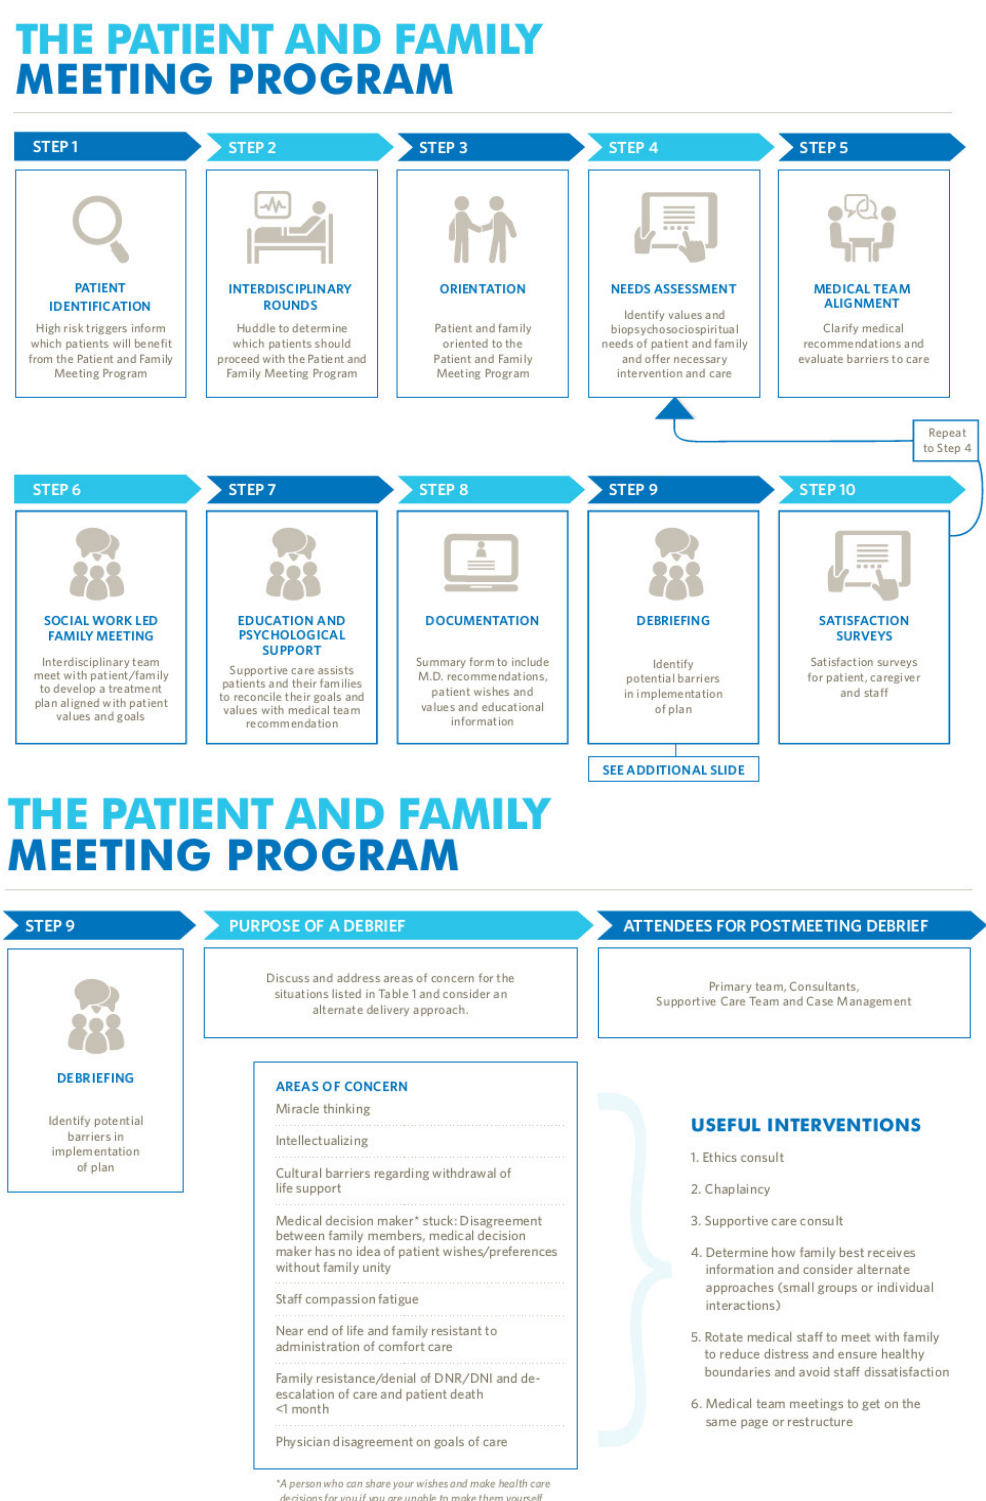
Figure 7. Ten-step supportive care patient and family meeting program pathway with expanded details about step 9 in second section of diagram to improve end of life care at